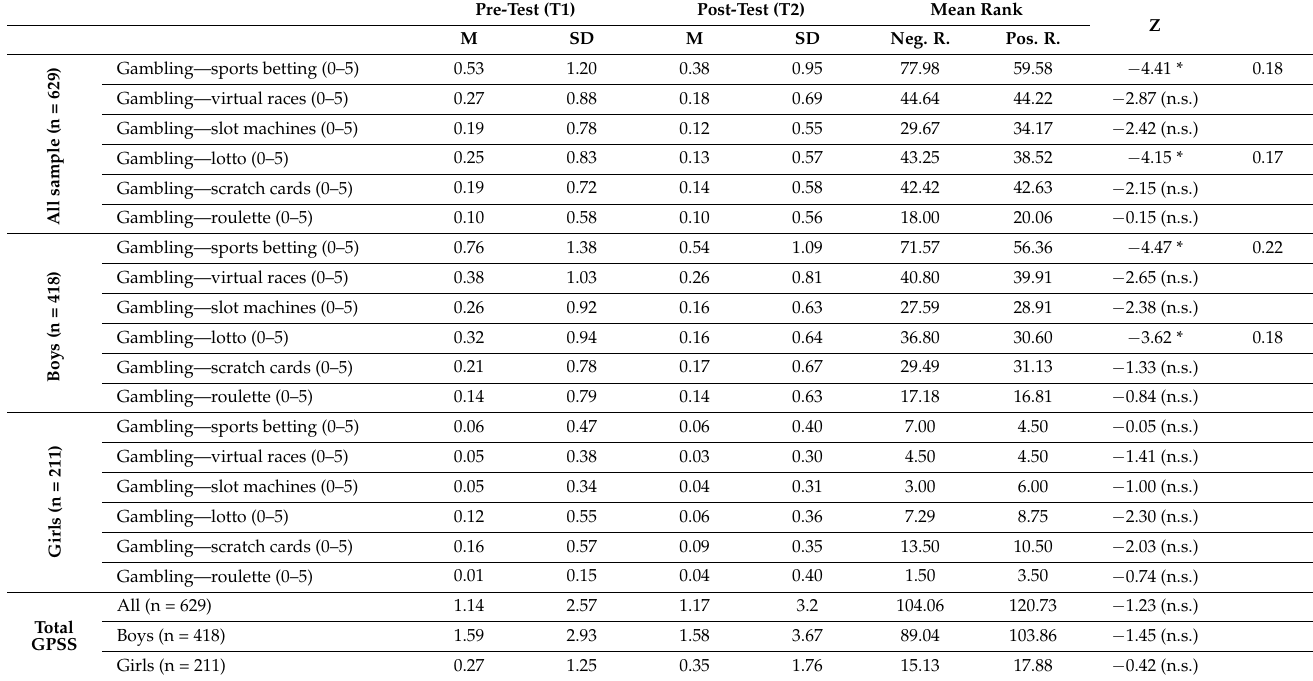
Table 4. Wilcoxon rank test on gambling behaviour and the total CAGI-GPSS